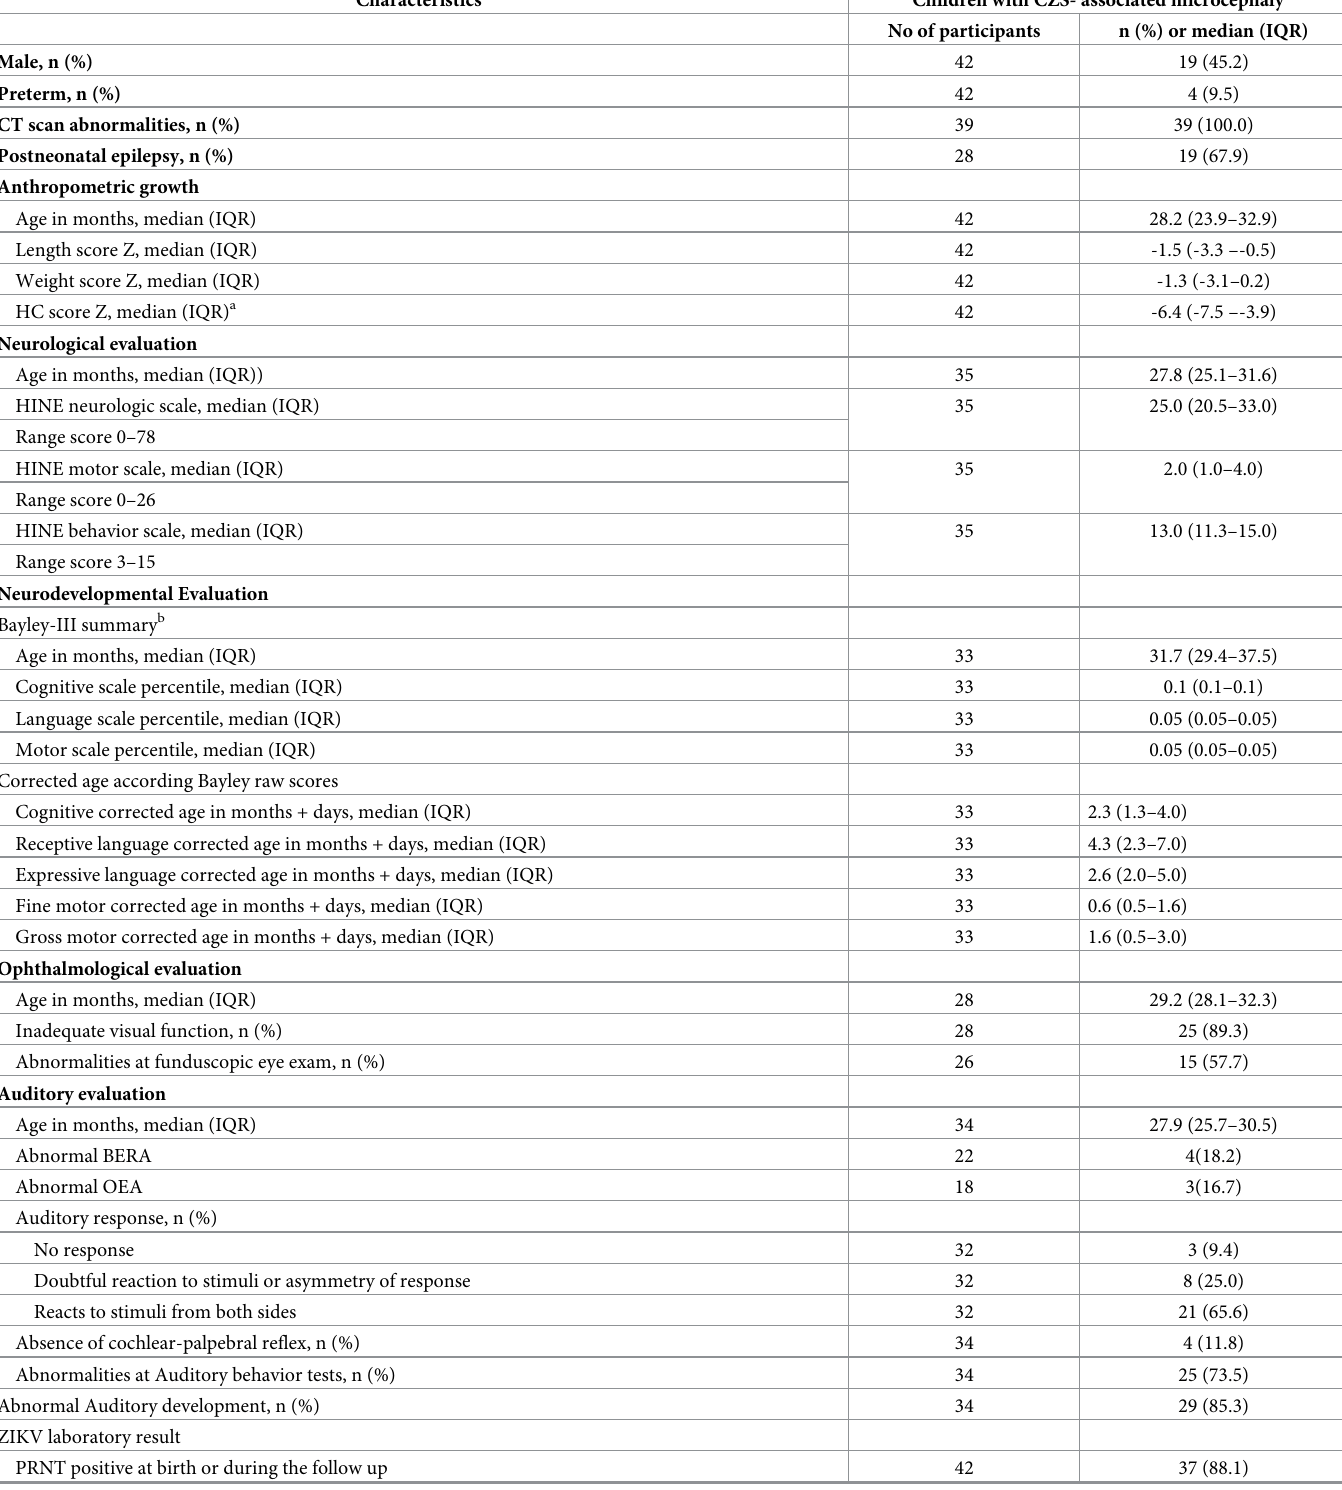
Table 1. Demographic characteristics and clinical, neurodevelopmental, and laboratory outcomes of children with CZS-associated microcephaly.